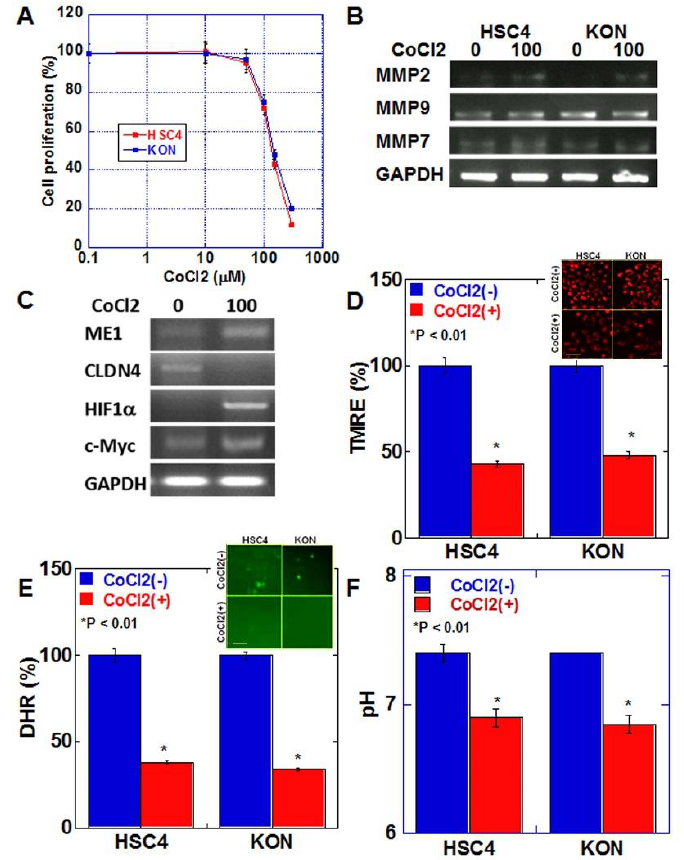
Figure 4. Effect of hypoxia on EMT and mitochondrial function in HSC4 and KON OSCC cells. ( A ) Effect of CoCl 2 -induced hypoxia on cell proliferation in HSC4 and KON OSCC cells. ( B ) Effect of hypoxia on mRNA expression of MMPs in HSC4 and KON OSCC cells. ( C ) Effect of hypoxia on mRNA expression of EMT-associated genes. ( D – F ) Effect of hypoxia on mitochondrial membrane potential (TMRE assay). ( D ), mitochondrial reactive oxygen species (ROS, DHR assay) ( E ), and extracellular pH ( F ). Inserts in ( D ) and ( E ) show fluorescent images. Error bar, standard deviation tested by Student’s t -test in three independent trials. Scale bar, 50 μm. GAPDH, glyceraldehyde 3- phosphate dehydrogenase; TMRE, tetramethylrhodamine ethyl ester; ROS, reactive oxygen species; DHR123, dihydrorhodamine 123.